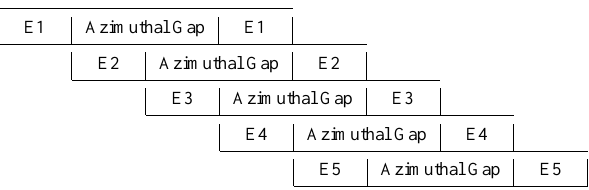
Table 1. Origin of gaps in azimuth at a fixed energy in the VDF